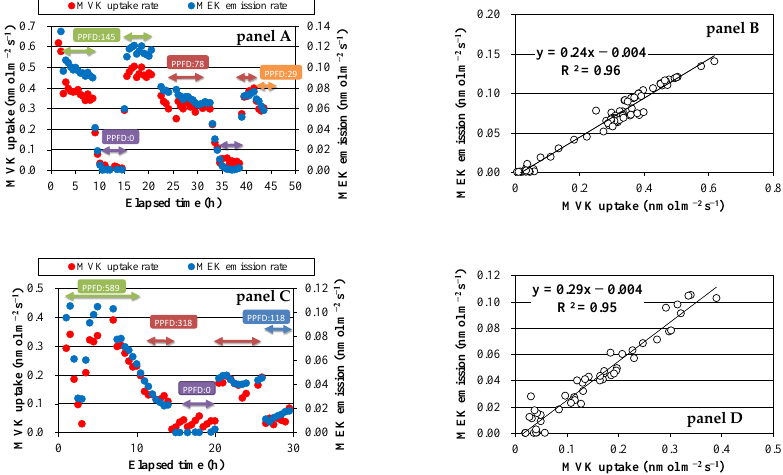
Figure 2. Time course of exchange rates of VOCs and their relationship. Panels A and B: MVK fumigation experiment using Spathiphyllum clevelandii ; panels C and D: MVK fumigation experiment using Quercus acutissima.